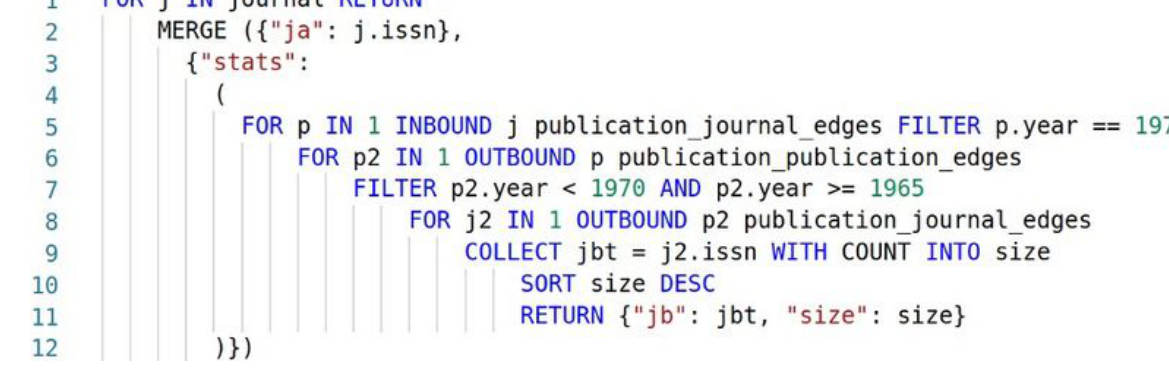
Figure 2. AQL query aggregating citations between journals. The query traverses the graph from journals to articles published in 1970, then to cited articles issued in five previous publications and then to journals of cited articles. We cycle over journals j from the collection media ; for each j we cycle over publications p from year 1970 connected to j by directed edges from the collection publication_journal_edges ; for each p we cycle over publications p2, cited by p (connected by edges from publications_publications_edges ); and finally we cycle by journals j2 in which publication p2 was published. The last three cycles are aggregated with a COLLECT statement and number of documents is COUNTed. INBOUND and OUTBOUND specify the direction in which directed edges are